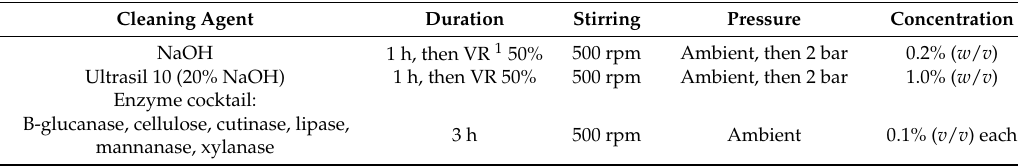
Table 2. Process parameters for each cleaning